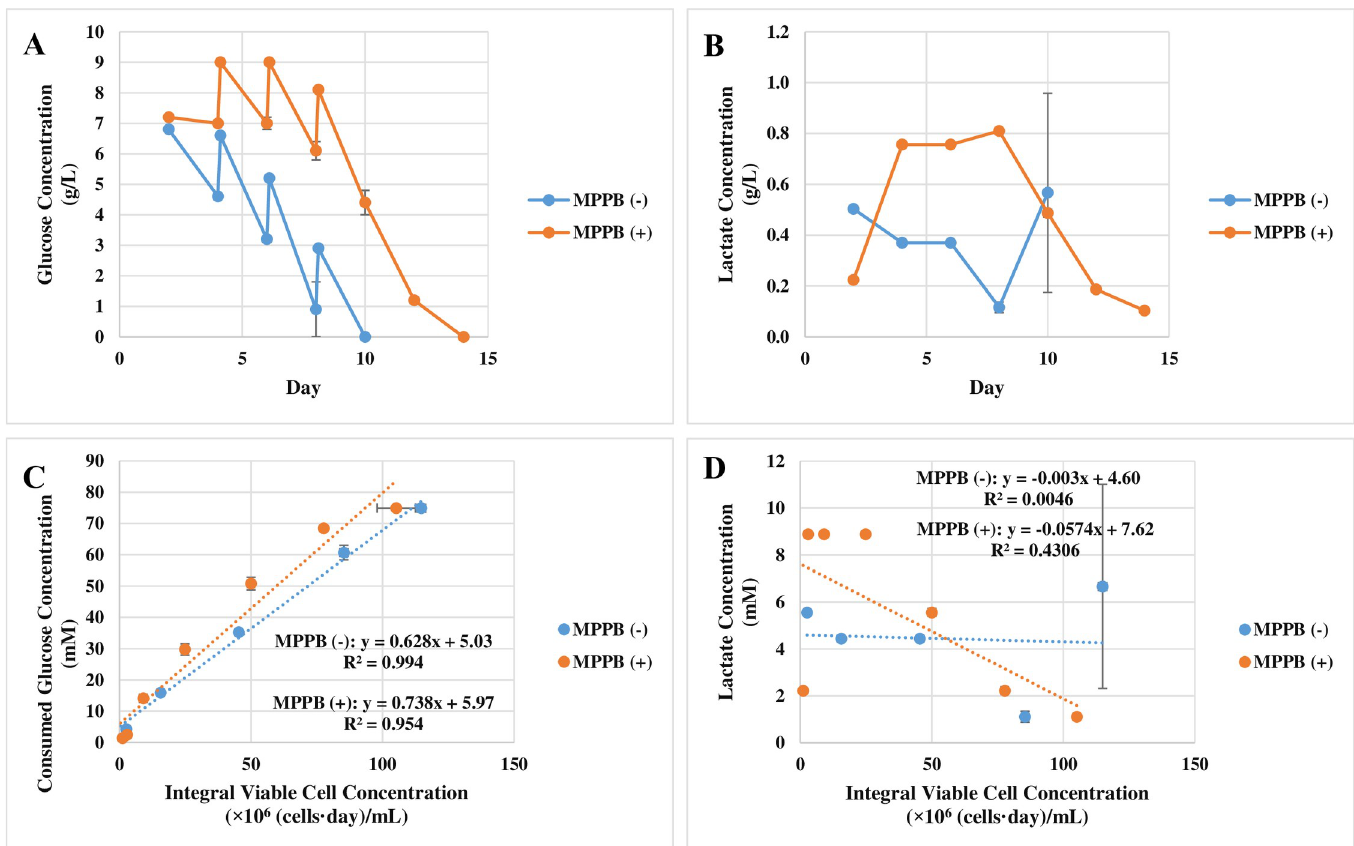
Fig 10. Metabolite analysis of the fed-batch cultures under the MPPB-added condition. Glucose concentration ( A ) and lactate concentration ( B ) were measured before adding the feed medium. Glucose concentration after adding the feed medium was calculated using the added feed medium amount. Cell-specific glucose uptake rates ( C ) and cell-specific lactate production rates ( D ) were indicated as the slopes of consumed glucose concentration and lactate concentration, respectively, against integral viable cell concentration [28, 29].